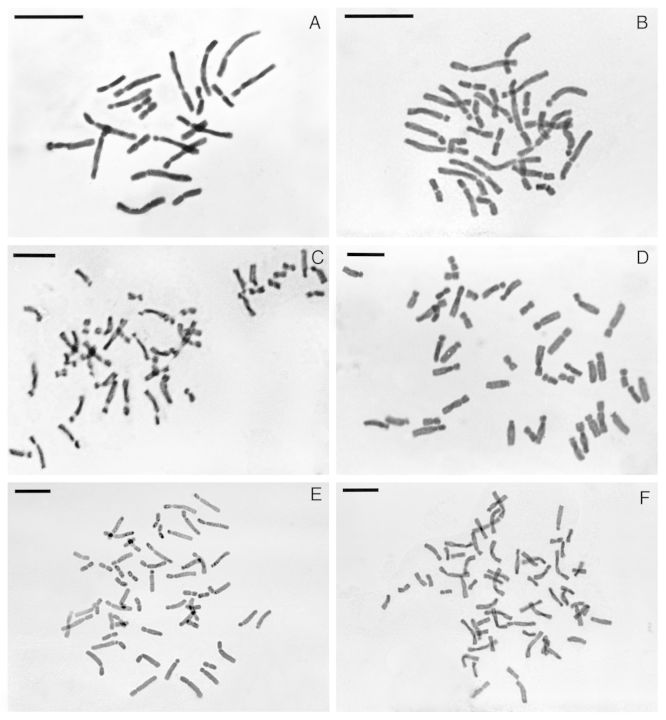
Mitotic metaphases of Hippeastrum species: (A) H. rutilum (2n = 22), (B) H. puniceum (2n = 33), (C) H. rutilum (2n = 44), (D) H. blossfeldiae (2n = 44), (E) H. cybister (2n = 55) and (F) H. puniceum (2n = 66). Scale bar: 10 µm.